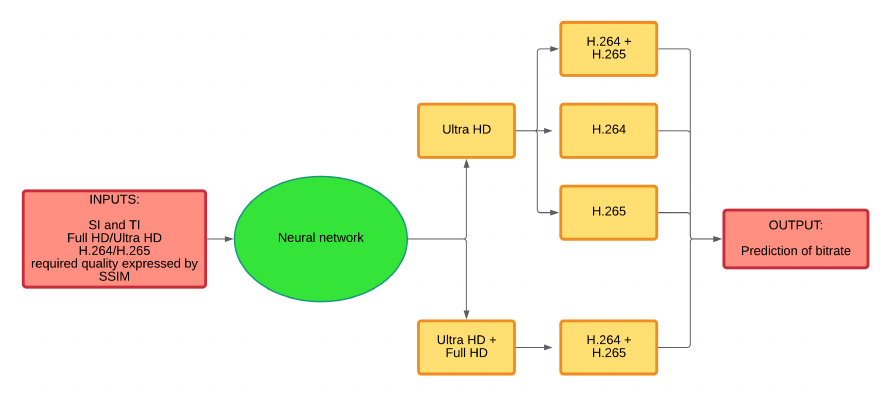
Figure 11. An example of the neural